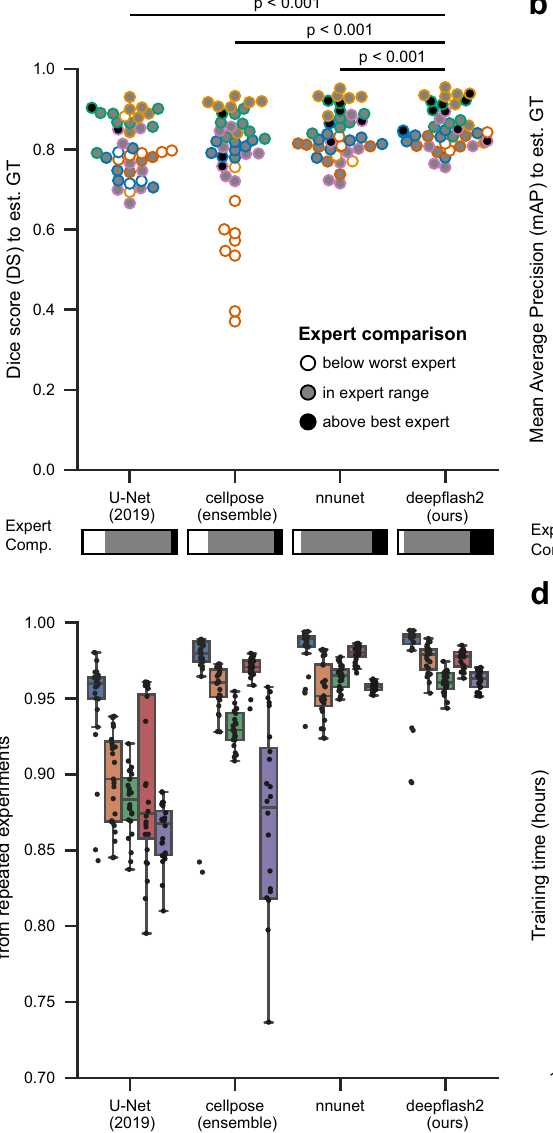
scored below the worst expert (white), in expert range (gray), or above the best expert (black). c Similarity of the predicted test segmentation masks for three repeated trainingruns withdifferenttraining-validationsplits( N =40,8imagesfor each dataset). Box plots are de fi ned as follows: the box extends from the fi rst quartile (lower bound ofthe box) tothe third quartile(upper bound of the box)of the data, with a center line at the median. The whiskers extend from the box by at most 1.5x the interquartile range and are drawn down to the lowest and up to the highest data point that falls within this distance. d Training speed (duration) on different platforms: Google Colaboratory (Colab, gratuitous Nvidia Tesla T4 GPU) and Google Cloud Platform (GPC, costly Nvidia A100 GPU). Source data are pro- vided as a Source Data fi